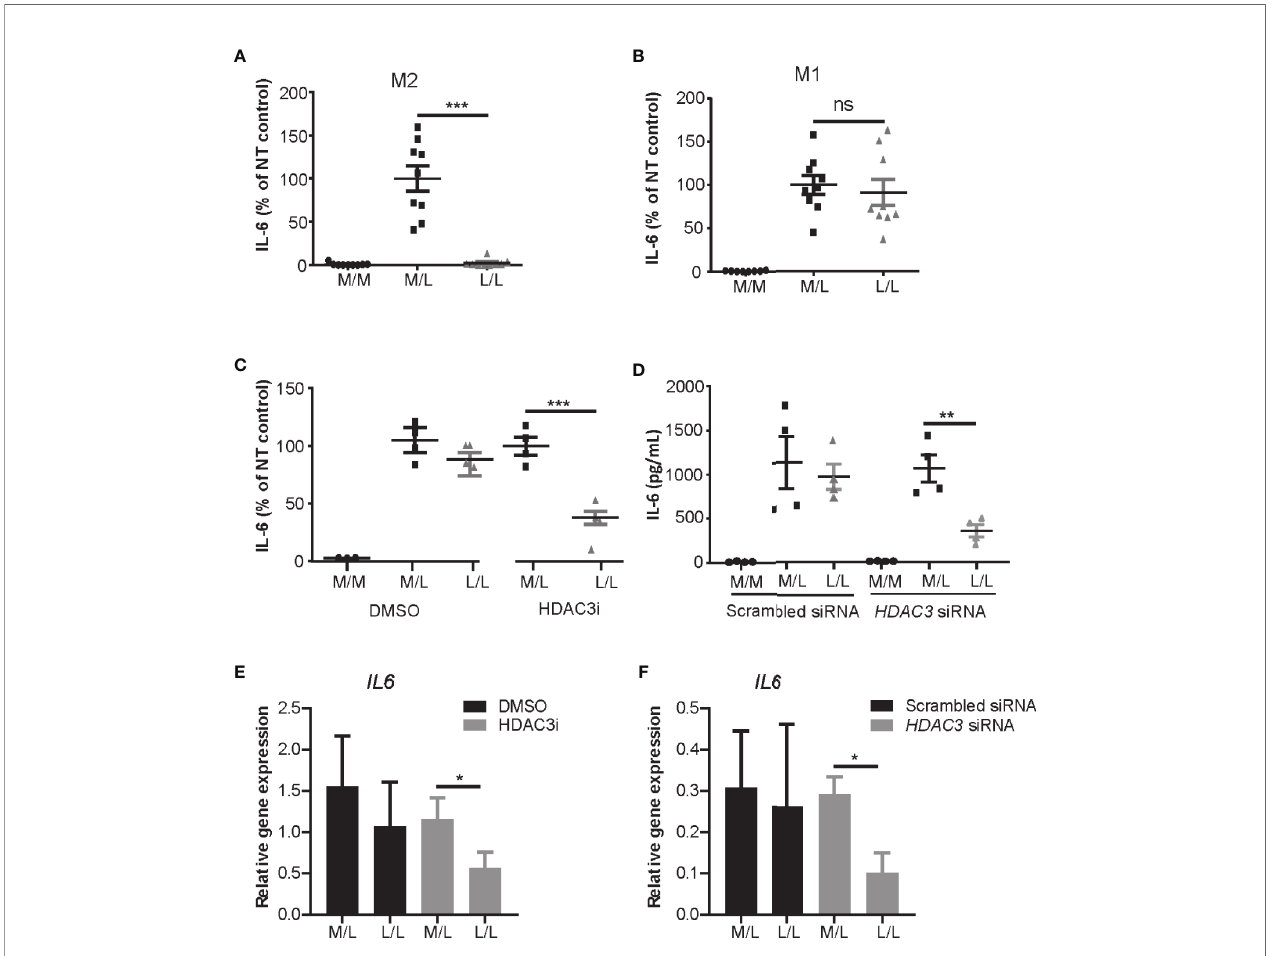
FIGURE 3 | HDAC3i and HDAC3 siRNA restored the impaired LPS-tolerance in M1 macrophages. Primary human CD14 + monocytes were polarized to M1 or M2 macrophages with IFN g or IL-4 for overnight, respectively, and then were tolerized ( “ L/L ” ) with 10 ng/mL LPS or were left non-tolerized ( “ M/L ” ) for 24 h after which they were exposed to 100 ng/mL LPS for 4 h. As a control, LPS-naïve sample was included as well ( “ M/M ” ). (A) Protein level of IL-6 in the supernatant was measured by ELISA in M2 (n=9) or in (B) M1 macrophages (n=9). (C) Primary human CD14 + monocytes were pretreated with DMSO control or 500 nM HDAC3i 30 min prior to polarization with IFN g . The cells were then “ L/L ” or “ M/L ” . IL-6 protein level was measured by ELISA (n=4). (D) Primary human CD14 + monocytes were pretreated with scrambled siRNA control or HDAC3 siRNA 48h prior to polarization with IFN g . The cells were then “ L/L ” or “ M/L ” . IL-6 protein level was measured by ELISA (n=4). (E) Relative gene expression of IL6 in DMSO- or HDAC3i-pretreated “ M/L ” and “ L/L ” macrophages (prepared as described above) (n=3). (F) Relative gene expression of IL6 in scrambled siRNA- or HDAC3 siRNA-pretreated NT and T macrophages (prepared as described above) (n=3). *P < 0.05; **P < 0.01; ***P < 0.001; n.s.: not signi fi